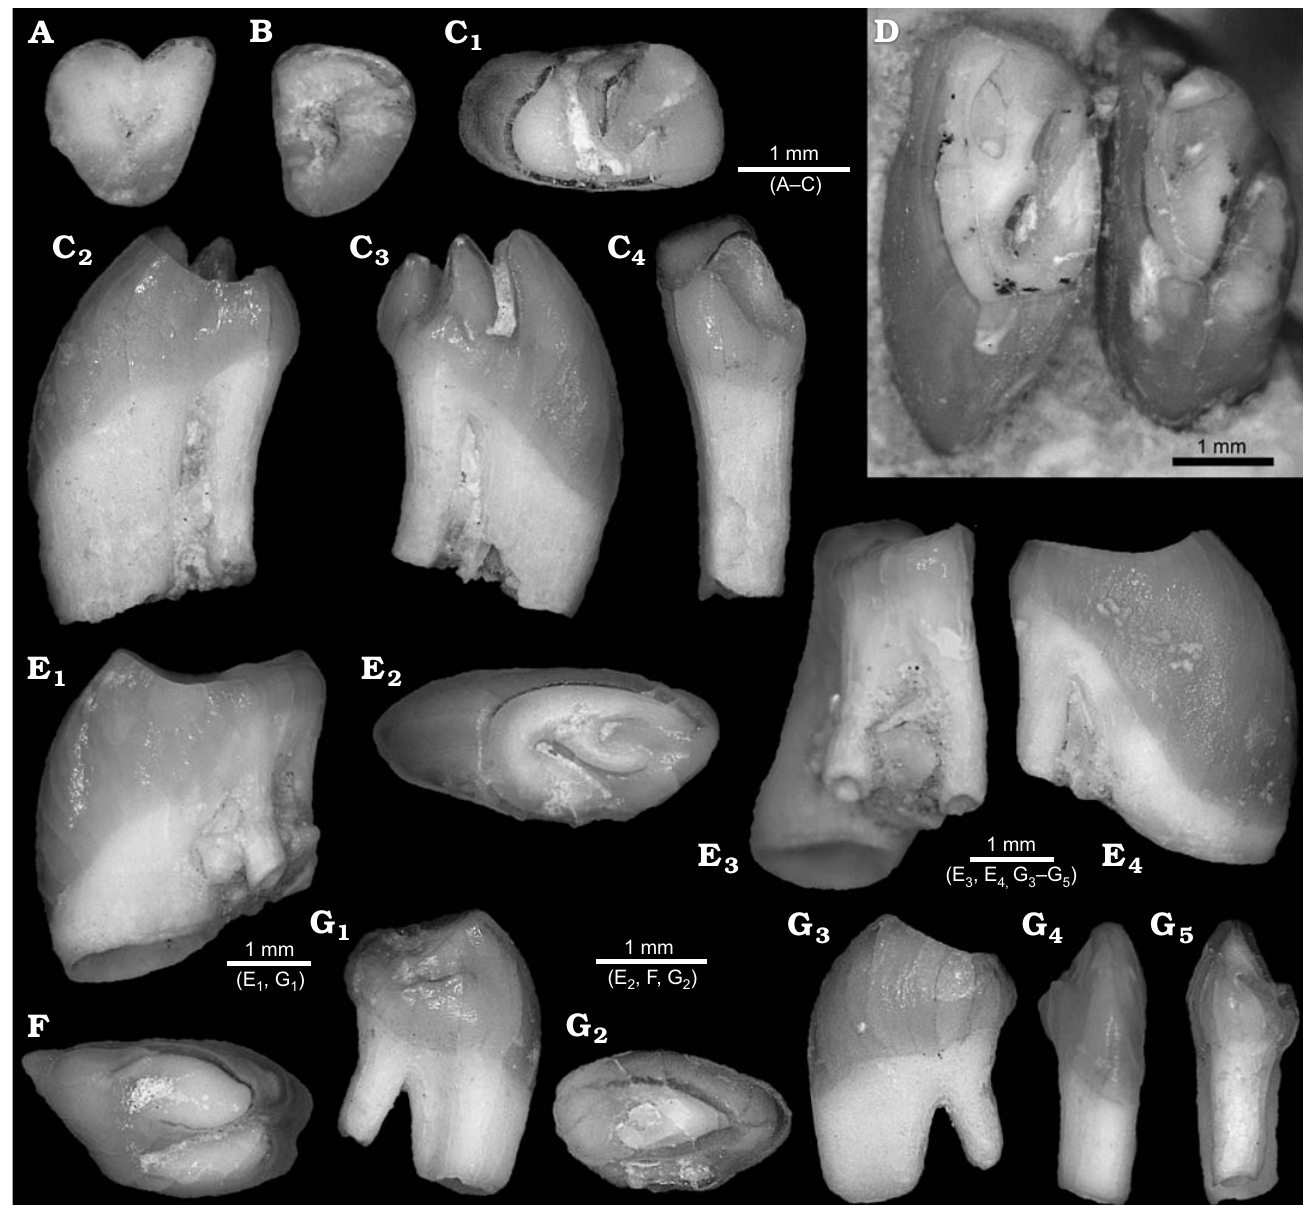
Fig. 9. Lagomorph Gobiolagus aliwusuensis Fostowicz-Frelik, Li, Meng, and Wang, 2012 from the Eocene of Wulanhuxiu, Nei Mongol, China. A . Cross section of the right DI2 (IVPP V20265.1). B . Cross section of the right di2 (IVPP V20265.1). C . Left P3 (IVPP V20265.3) in occlusal (C 1 ), posterior (C 2 ), anterior (C 3 ), and lingual (C 4 ) views. D . Associated left M1–M2 (IVPP V20263.1) in occlusal view. E . Left M2 (IVPP V20265.9) in posterior (E 1 ), occlusal (E 2 ), buccal (E 3 ), and anterior (E 4 ) views. F . Right juvenile M2 (IVPP V20265.8) in occlusal view. G . Right M3 (IVPP V20265.11) in posterior (G 1 ), occlusal (G 2 ), anterior (G 3 ), lingual (G 4 ), and buccal (G 5 )